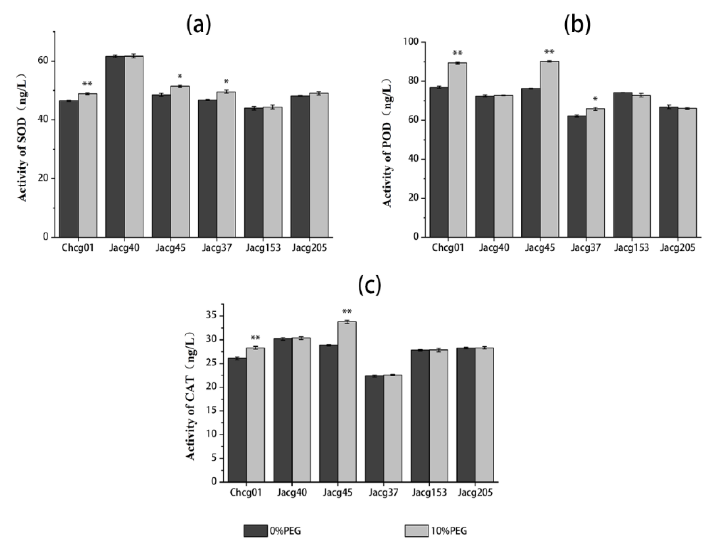
Figure 2. The activities of superoxide dismutase (SOD, ( a )), peroxidase (POD, ( b )), and catalase (CAT, ( c )) in the mycelia of six strains of Cenococcum geophilum under drought treatment. The mycelia were pre-cultured in a modified MMN medium for 30 days, followed by the drought treatment (10% PEG-6000) for 30 days. PEG-6000 was not added into the control treatment. Data are shown as mean ± SD of the replicates (n = 3). Significant difference of the activities of SOD, POD, and CAT after the drought treatment is analyzed by using the Student’s t -test. * p < 0.05; ** p <